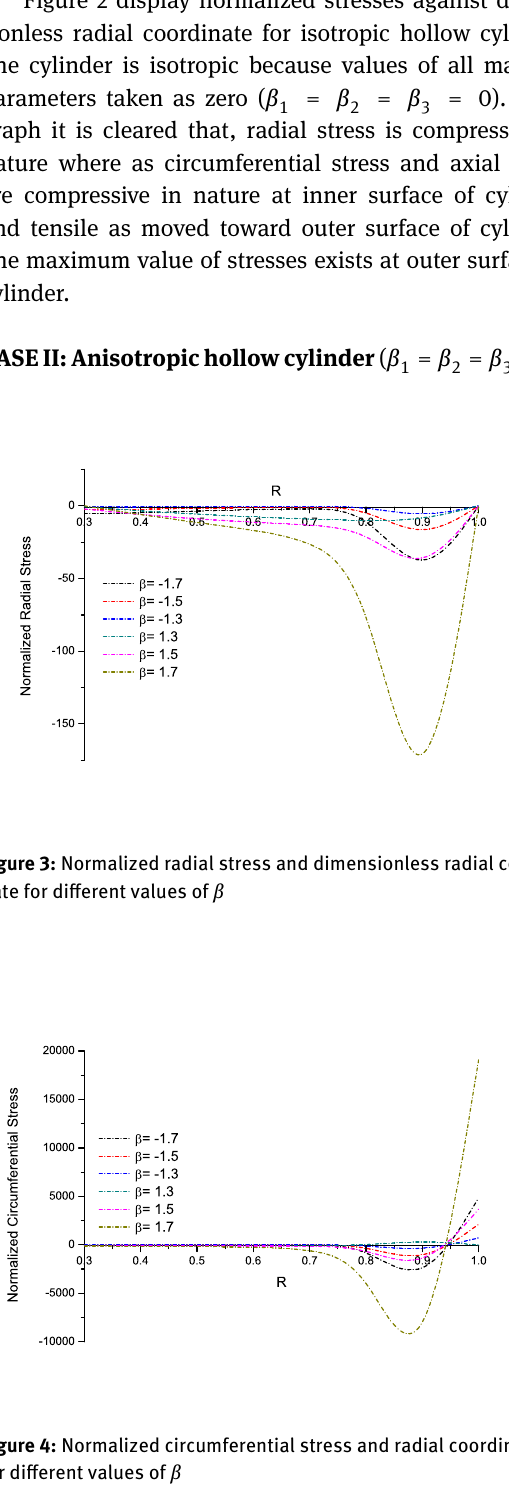
Figure 6: Normalized radial stress distribution in FGM hollow cylin- der with different values T